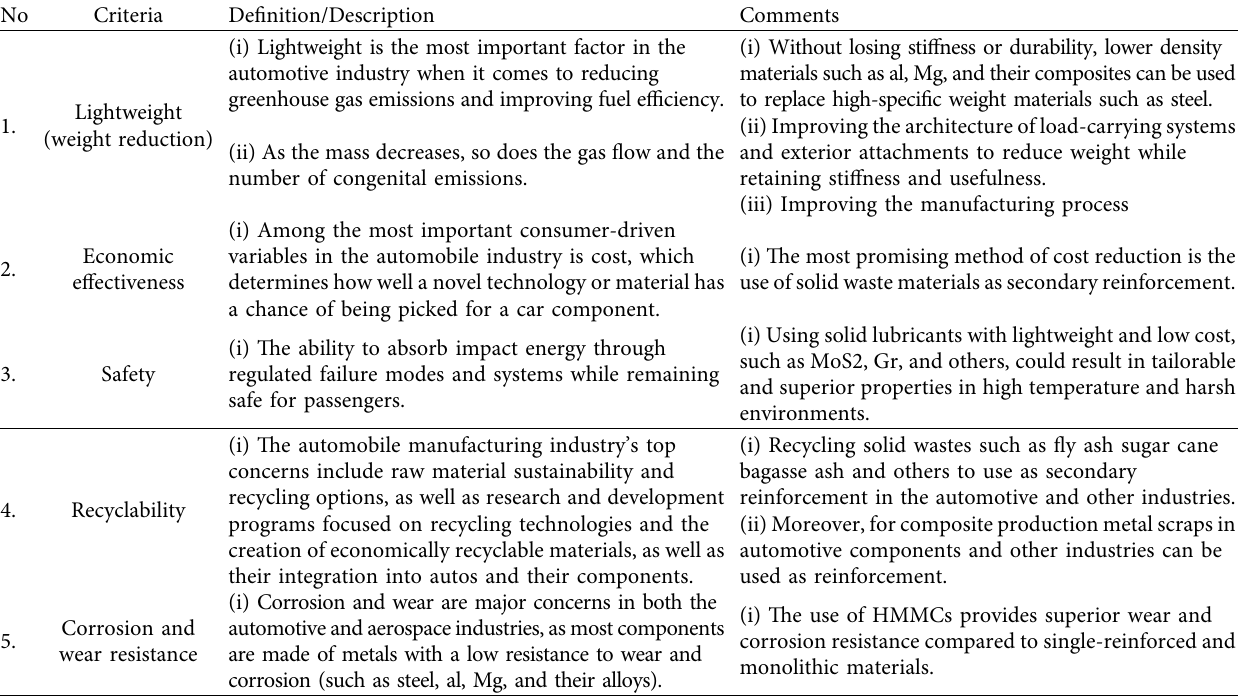
Table 10: 'e important criteria that material should meet for the automobile and aerospace industries [133, 134]. No